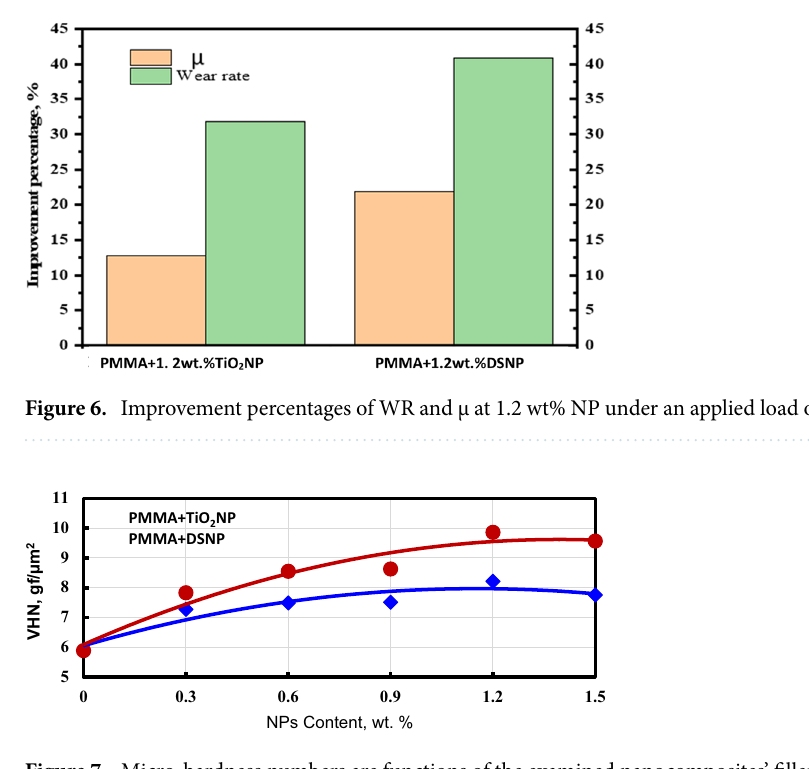
Figure 7. Micro-hardness numbers are functions of the examined nanocomposites’ filler